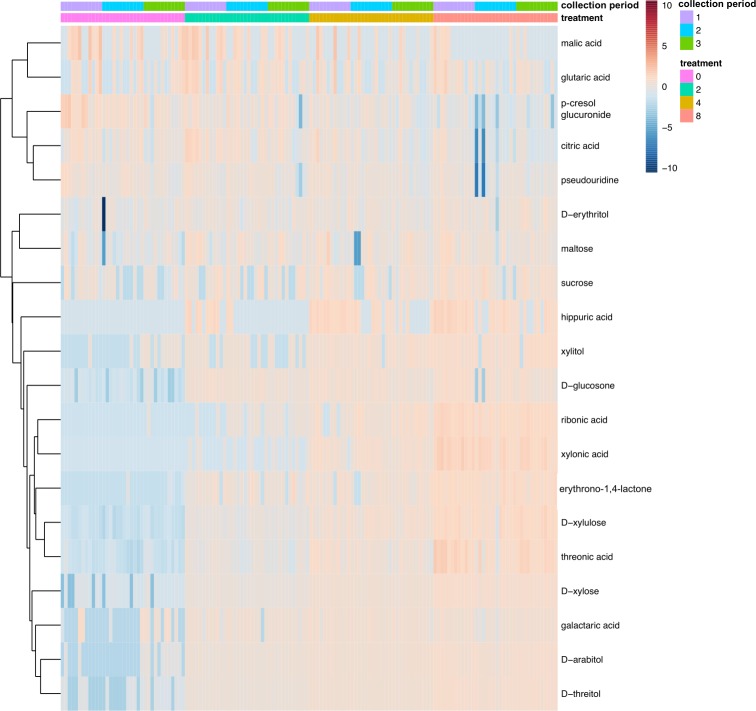
Two-way heat map visualization and hierarchical clustering of urine metabolite distribution.Pigs (n = 12/treatment) were fed diets containing either 0, 2, 4, or 8% D-xylose and 3 different collection periods were utilized to represent increasing adaptation time to treatment diets. The rows display the metabolites and the columns represent individual samples. Relative urinary metabolite excretion (g/d, log transformed) is represented in the heat map by colors, which correspond to the magnitude of difference when compared with the average value for the metabolite. Only metabolites significantly (adjusted P ≤ 0.05) impacted by treatment (% dietary xylose inclusion; 0, 2, 4, or 8%), collection period (1 = d 5–7, 2 = d 12–14, 3 = d 19–21), or their interaction are displayed. Significance was determined using two-way ANOVA.